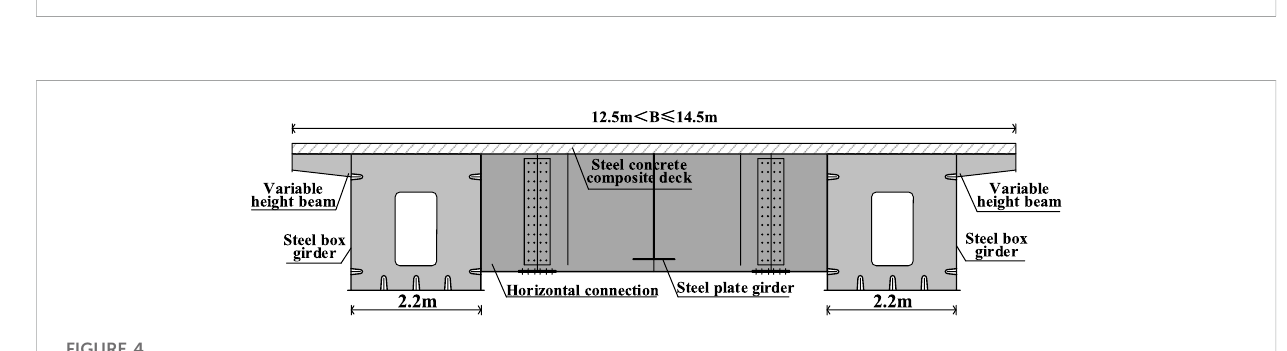
One I-shaped steel plate girder in the middle of double steel side box